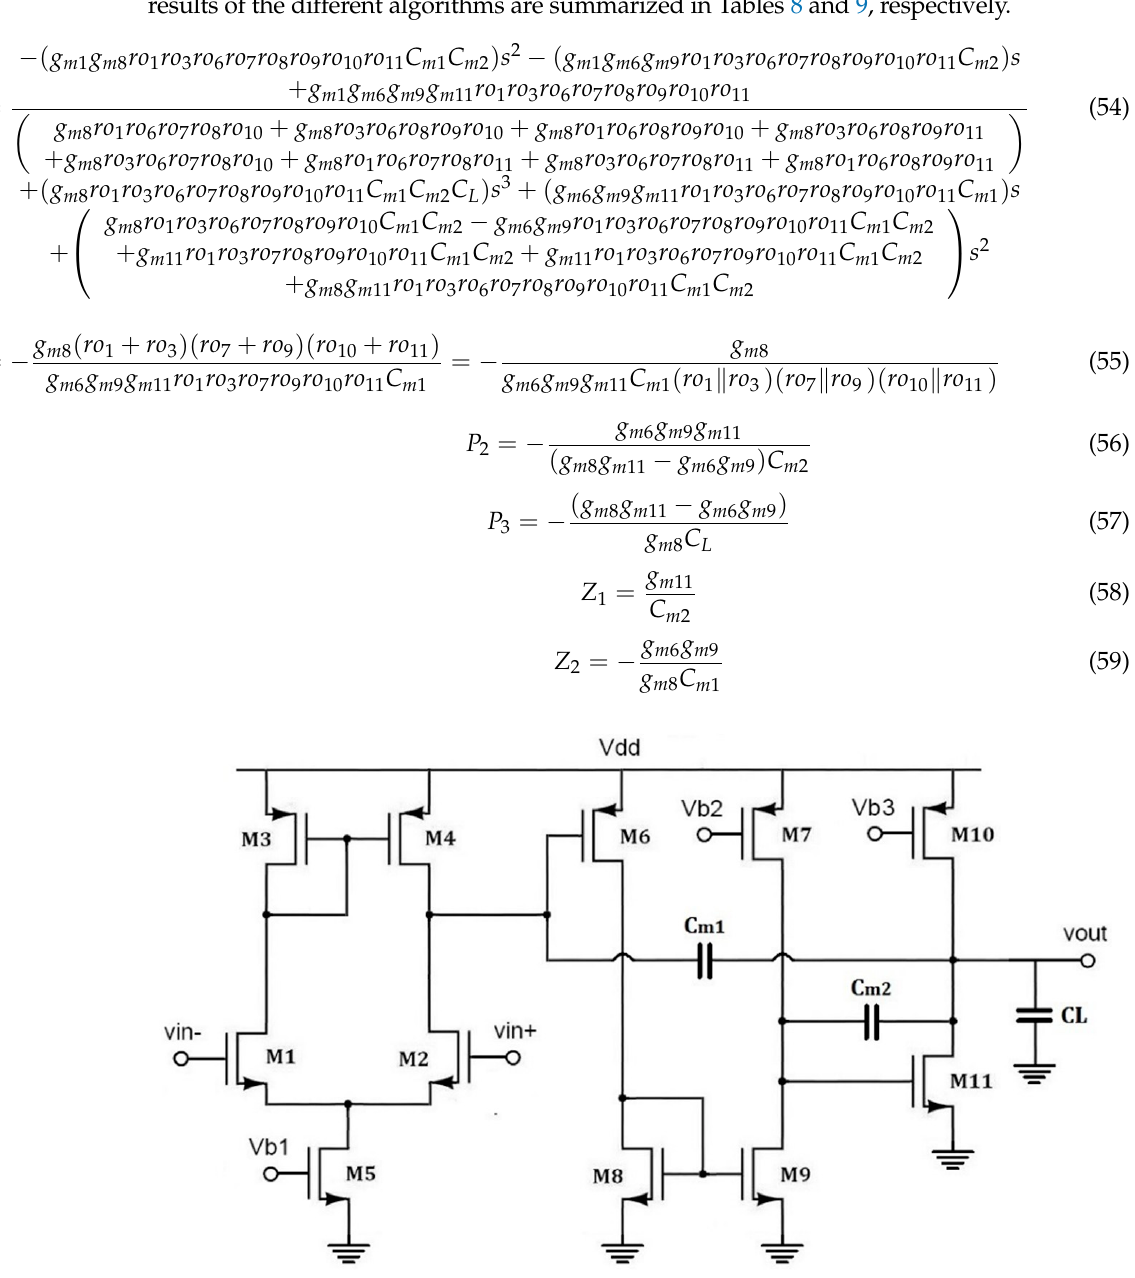
Figure 8. A three-stage ampli fi er in the transistor model. Table 8. Number of terms within the simpli fi ed symbolic poles/zeroes in Circuit 3.